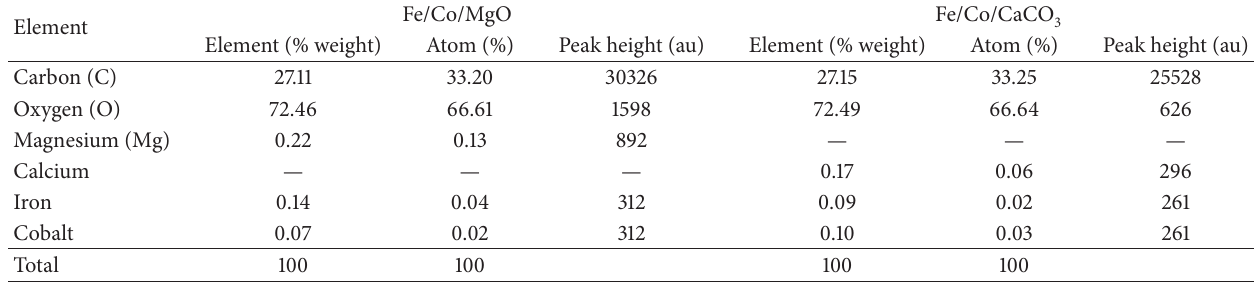
Table1:QuantitativeanalysisofelementsandatomsobtainedfromenergydispersivespectroscopyofFe/Cocatalystsupportedonmagnesium oxide and calcium